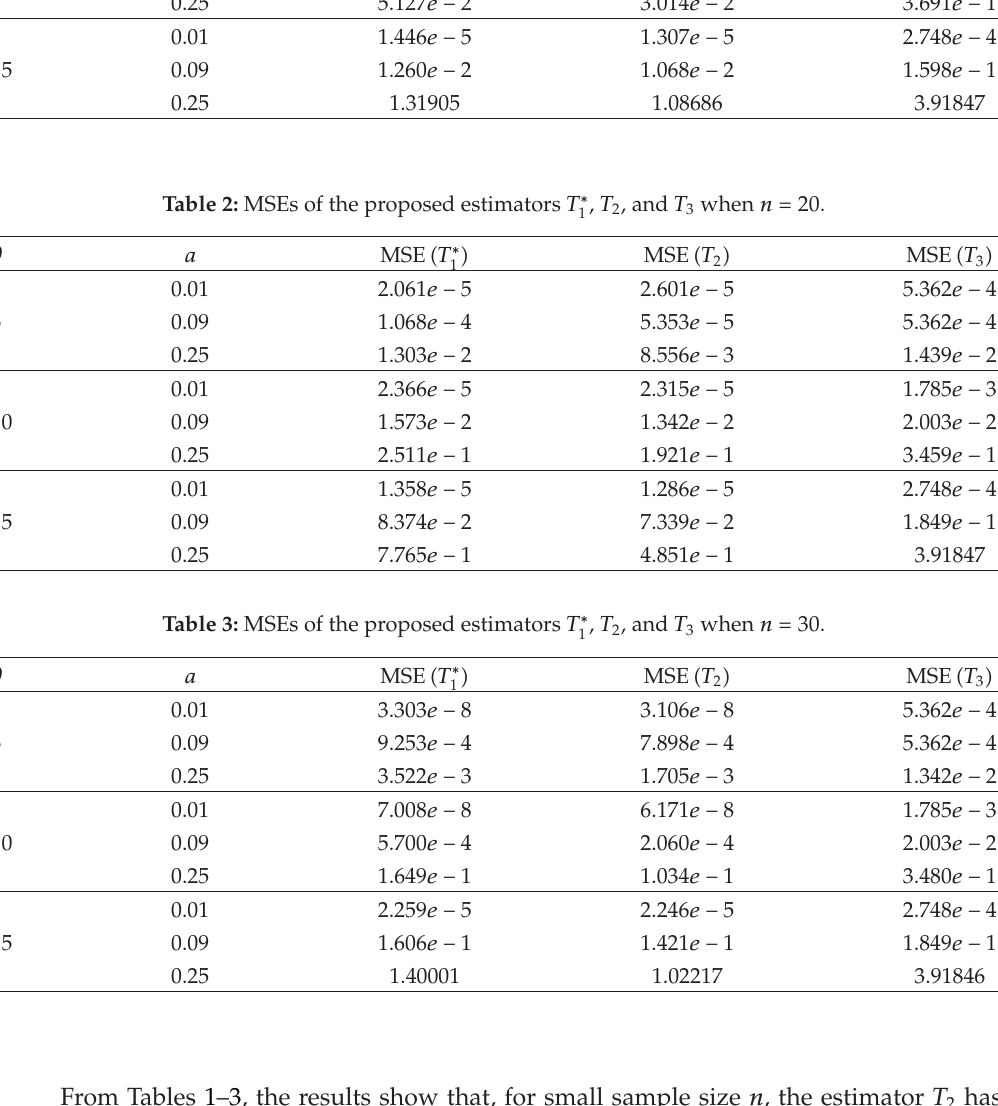
Table 2: MSEs of the proposed estimators T ∗